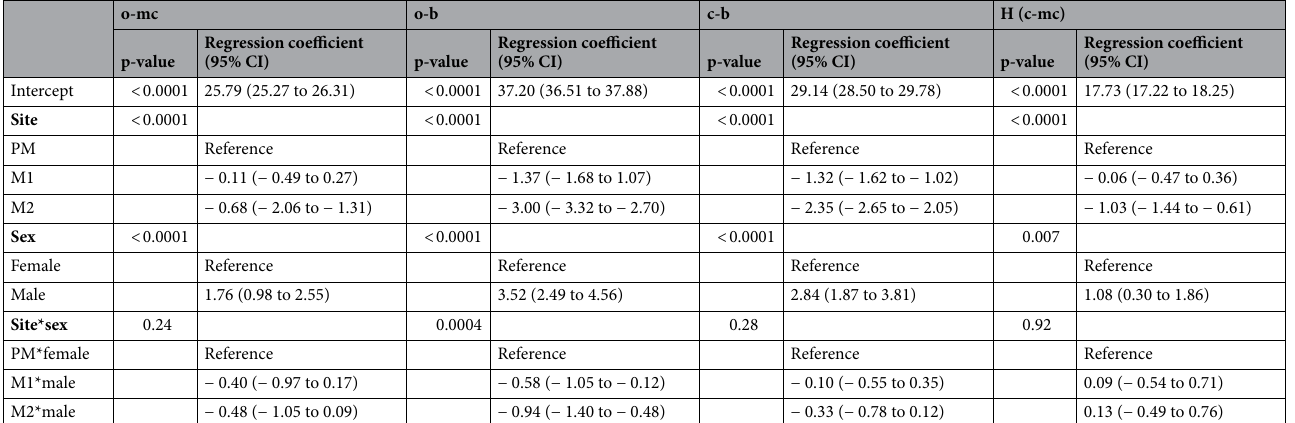
Table 4. Multivariable analysis of alveolar bone height (BH) measurements. PM: second premolar. M1: first molar. M2: second molar. o-mc: distance between the occlusal plane and the most coronal point of